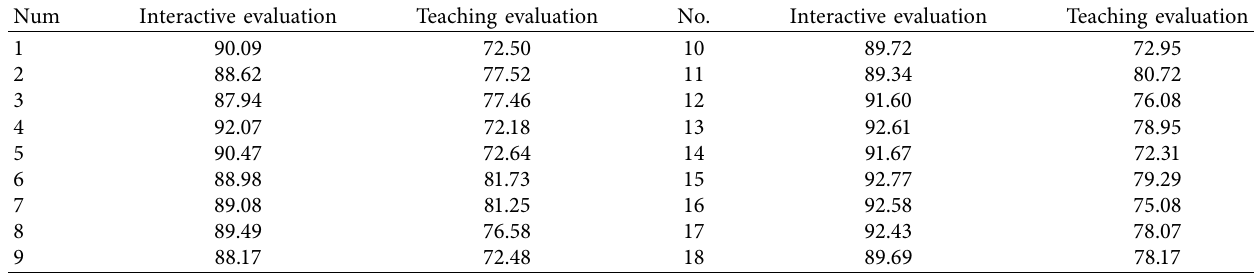
Table 1: Evaluation of interactive English translation teaching mode based on differential evolution algorithm. Num Interactive evaluation